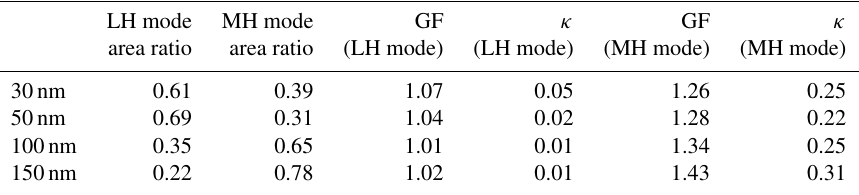
Table 1. The area ratio, GF value, and κ value for the less hygroscopic (LH) mode and more hygroscopic (MH) mode for four dry diameters for all three types of aerosols.